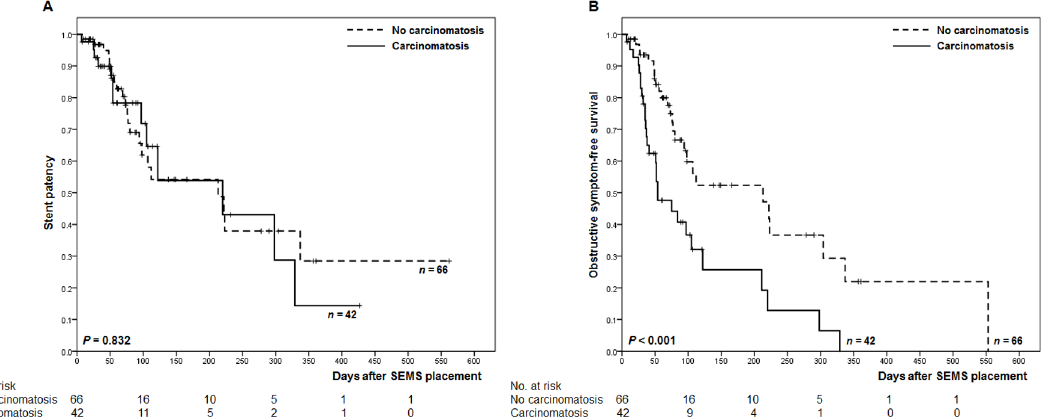
Fig 2. Kaplan-Meier curve of stent patency and obstructive symptom-free survival according to the presence of carcinomatosis. (A) stent patency. (B) obstructive symptom-free survival.